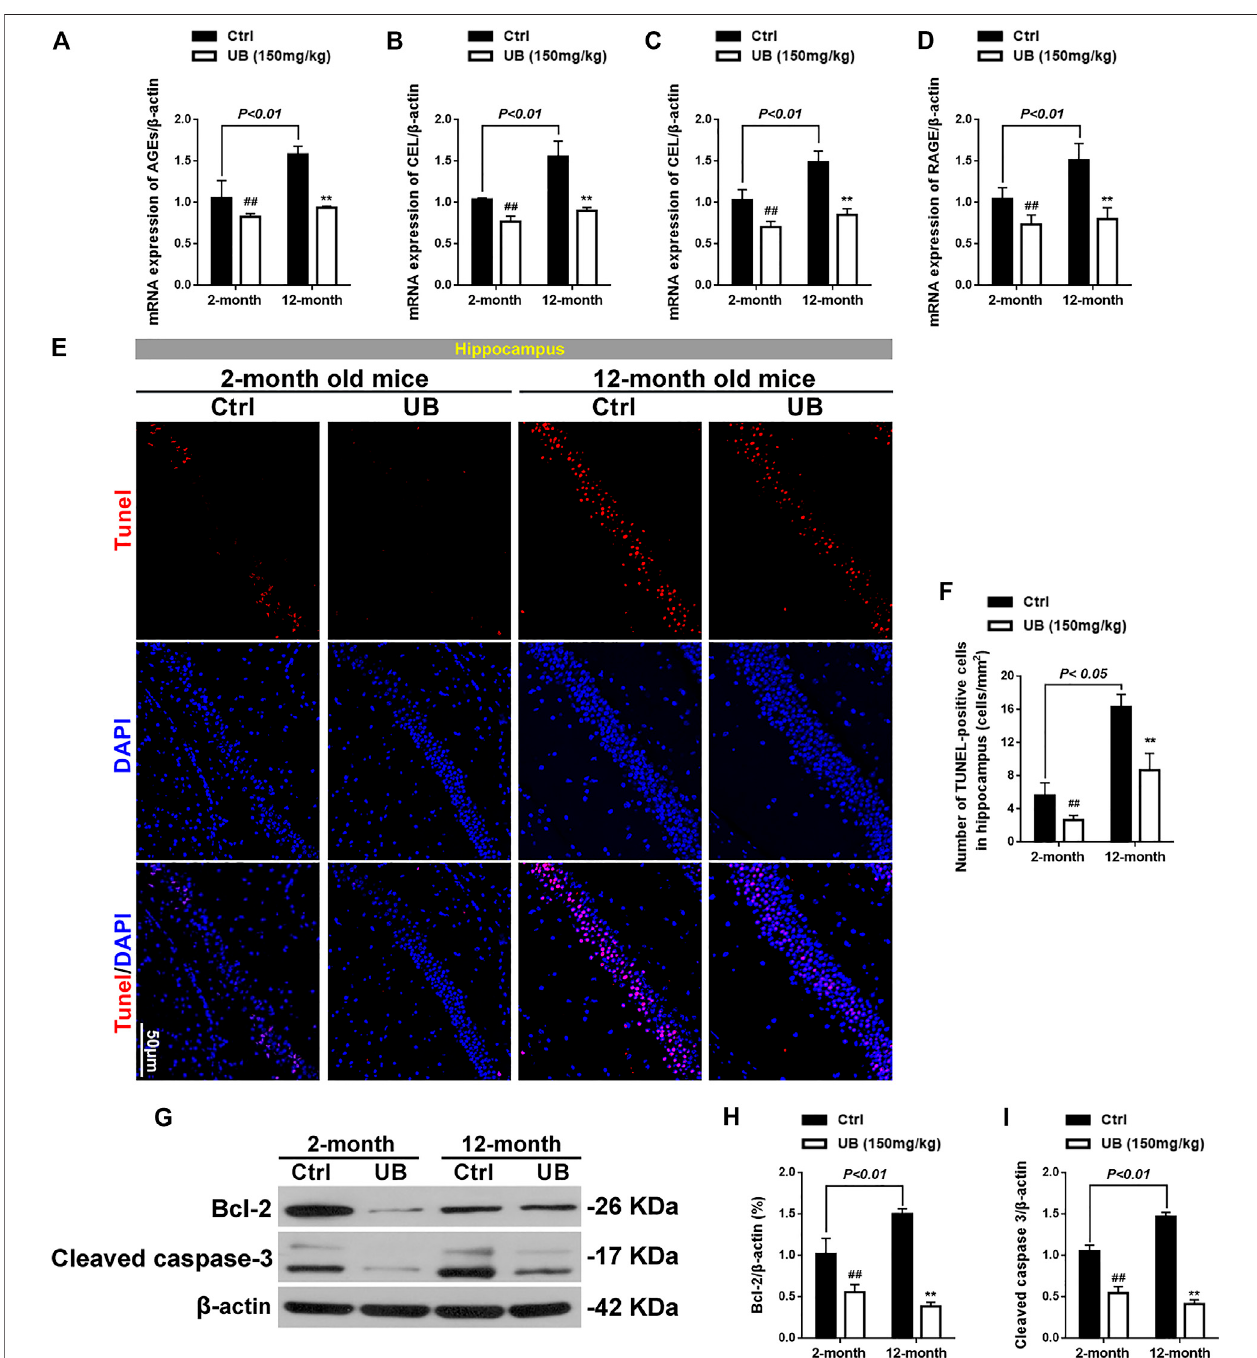
FIGURE7| ExpressionofAGEs (A) ,CML (B) ,CEL (C) and RAGE (D) in2-months- and 12-months-old mice byquantitativeRT-PCR ( n (cid:1) 6per group). (E) TUNEL assayswereperformedtoevaluate apoptosis inthehippocampus ofnormalyoungand naturally senilemice invivo. (F) Therelativeproportion ofTUNEL-positivecellsin the hippocampus of normal young and naturally senile mice ( n (cid:1) 6 per group). (G) Protein expression of Bcl-2 and cleaved caspase-3 in the brains of normal young and naturallysenilemicewasdetectedbywesternblotting.Quanti fi cationanalysisofBcl-2 (H) andcleavedcaspase-3 (I) . β -actinservedasaninternalcontrol( n (cid:1) 6per group). All results are described as means ± SD. # p < 0.05 and ## p < 0.01 vs the control group; * p < 0.05 and ** p < 0.01 vs the 12-months-old aging group.